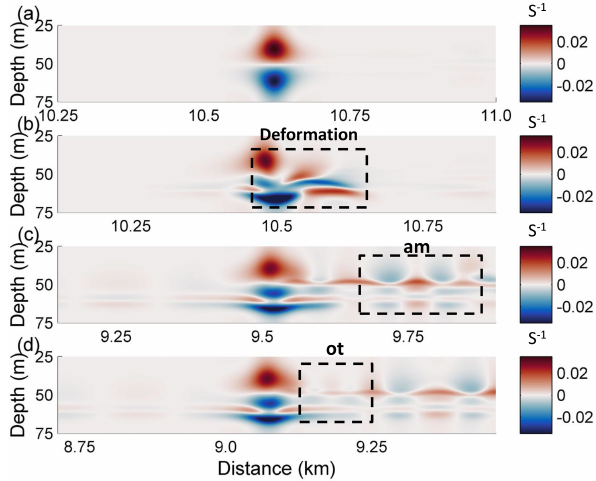
Figure 6. Hovmöller plot of horizontal velocity without the back- ground shear current at the surface. The mode-2 ISW, forward- propagating long wave, oscillating tail and amplitude-modulated wave packet are denoted by “m2”, “fp”, “ot” and “am”, respectively.